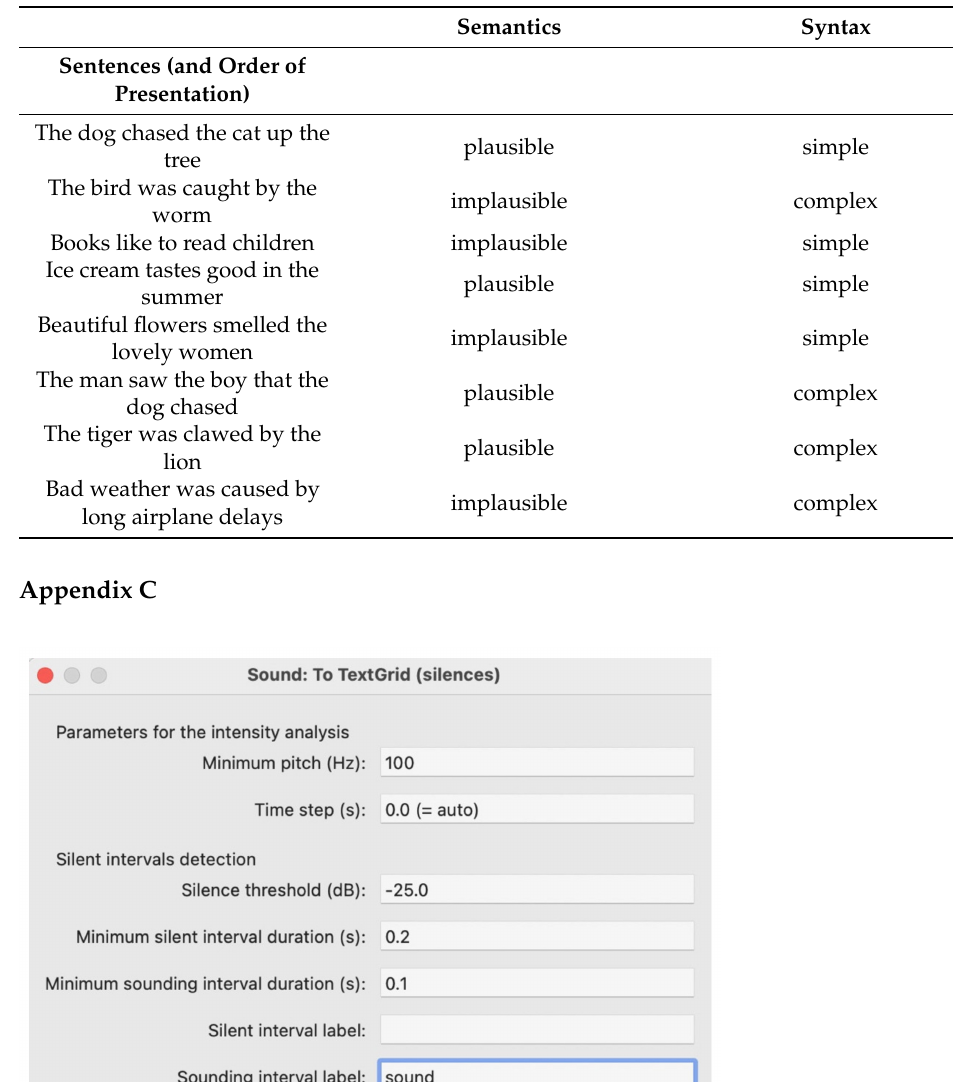
Table A2. Sentence recall stimuli.